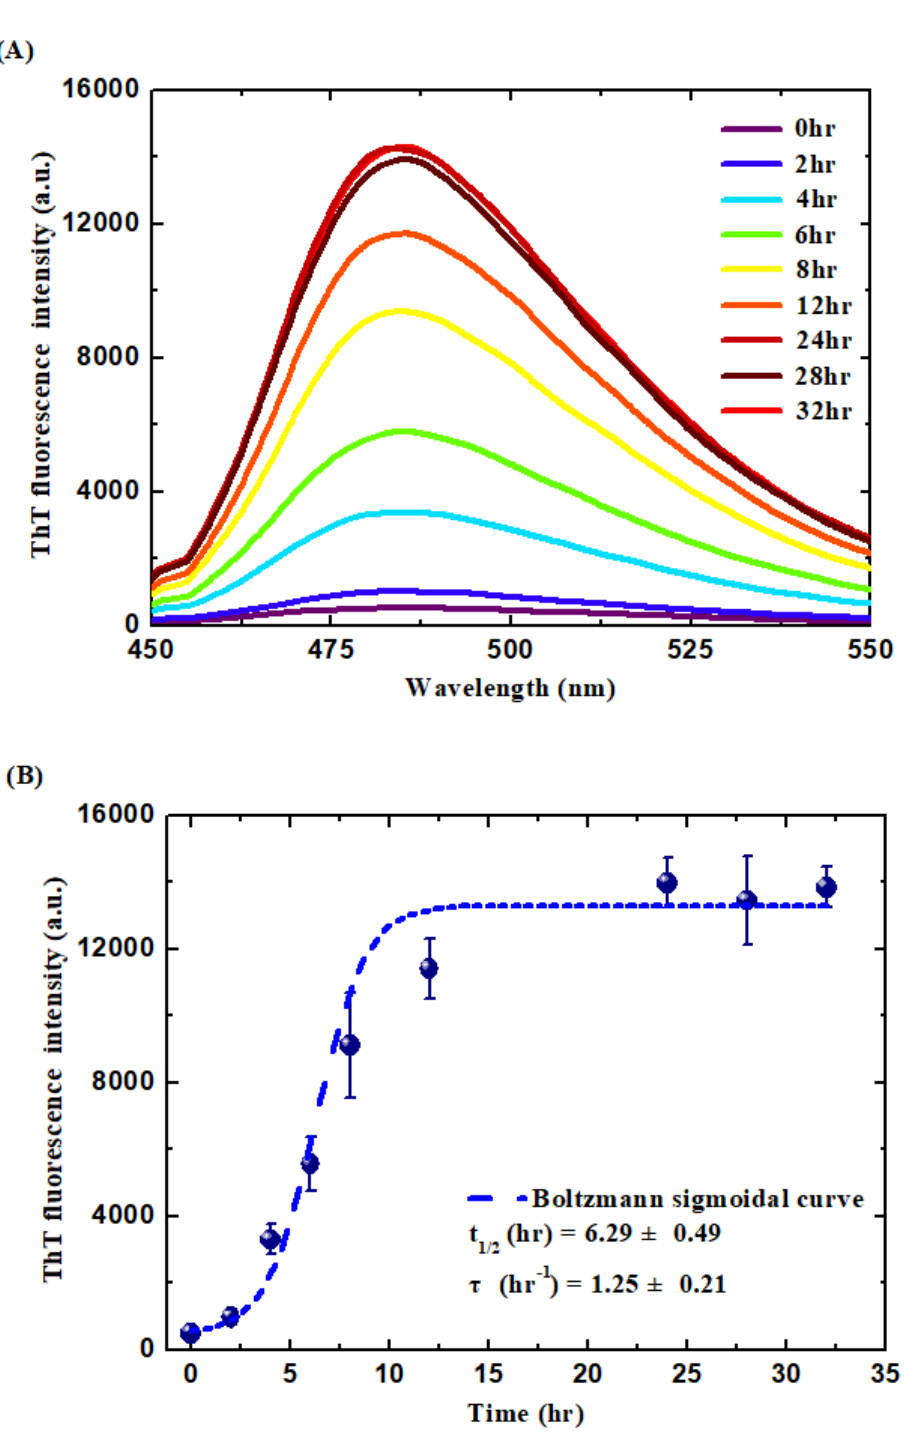
Figure 1. Formation of whey protein isolate amyloid fibrils as revealed by ThT binding assay. ( A ) ThT fluorescence spectra of WPI-AF at different incubation times. ( B ) ThT fluorescence intensity of WPI-AF as a function of incubation time. Boltzmann sigmoidal curve was employed to fit against the ThT fluorescence data. (The excitation wavelength = 440 nm, and the emission wavelength = 440–490 nm).